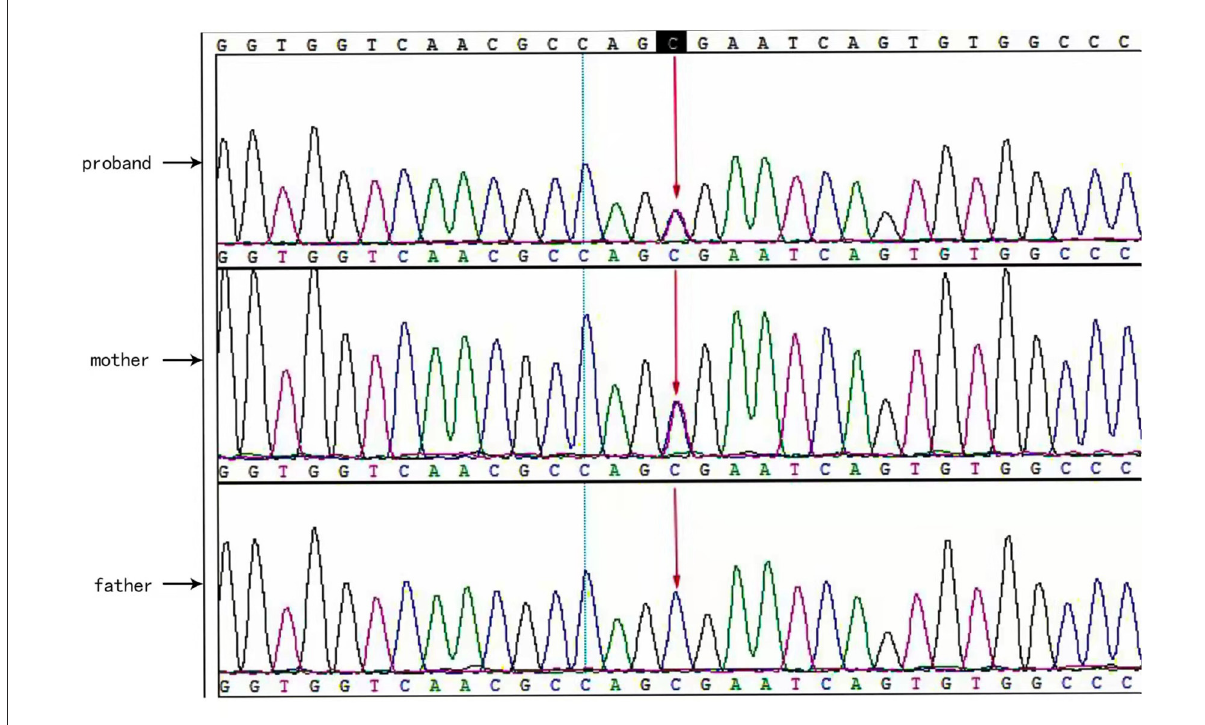
FIGURE2 ABCC8 gene c.2506C > T mutated sequence in the proband. Arrows indicate the mutation site.